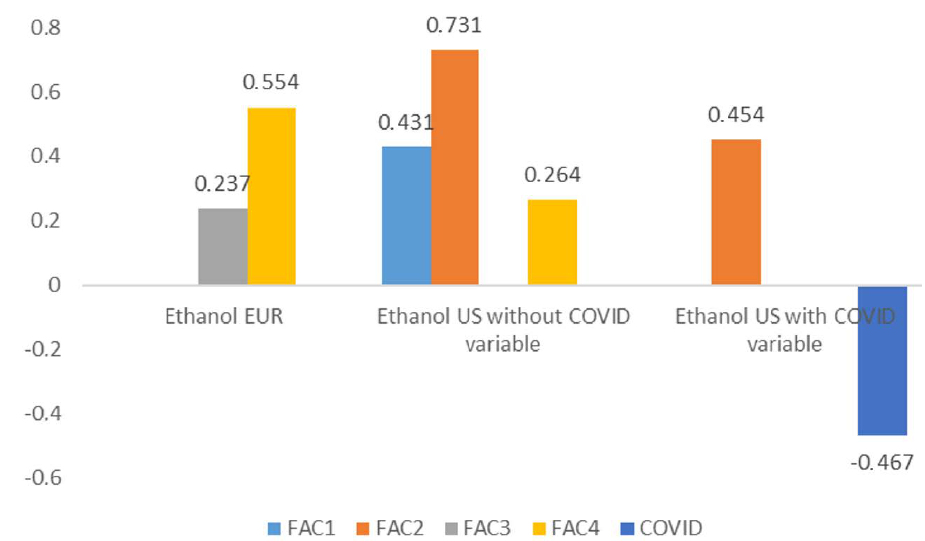
Figure 12. Impacts of the different factors influencing ethanol prices. Source: Authors’